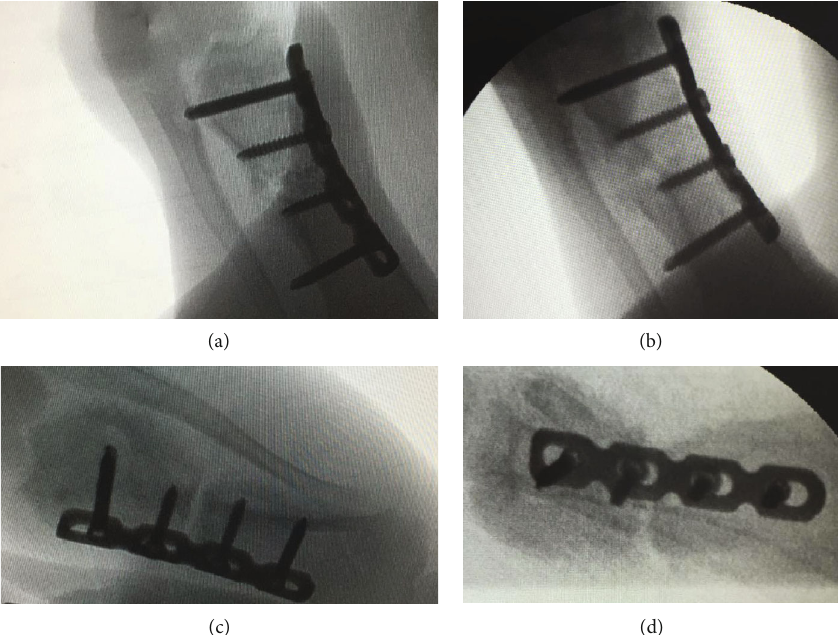
Figure 4: Models of defects B1 and B2 and radiography. Time-dependent radiological changes in the defect, 4 and 8 weeks after reconstruction. (a, b) 4 and 8 weeks after reconstruction, the Tibia 3 showing bone bridge connecting the defect B1. (c, d) 4 and 8 weeks after reconstruction, the Tibia 4 showing overgrowth of callus upon bilateral ends aside the defect B2, without crossing the